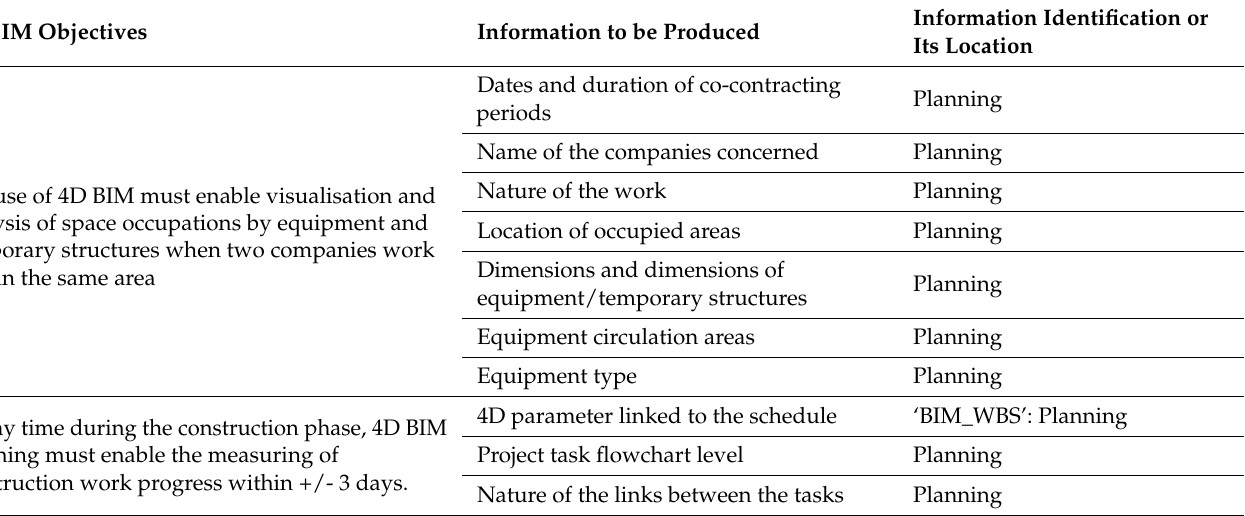
Table 3. Summary of the information produced at Step 3 of Phase 3.